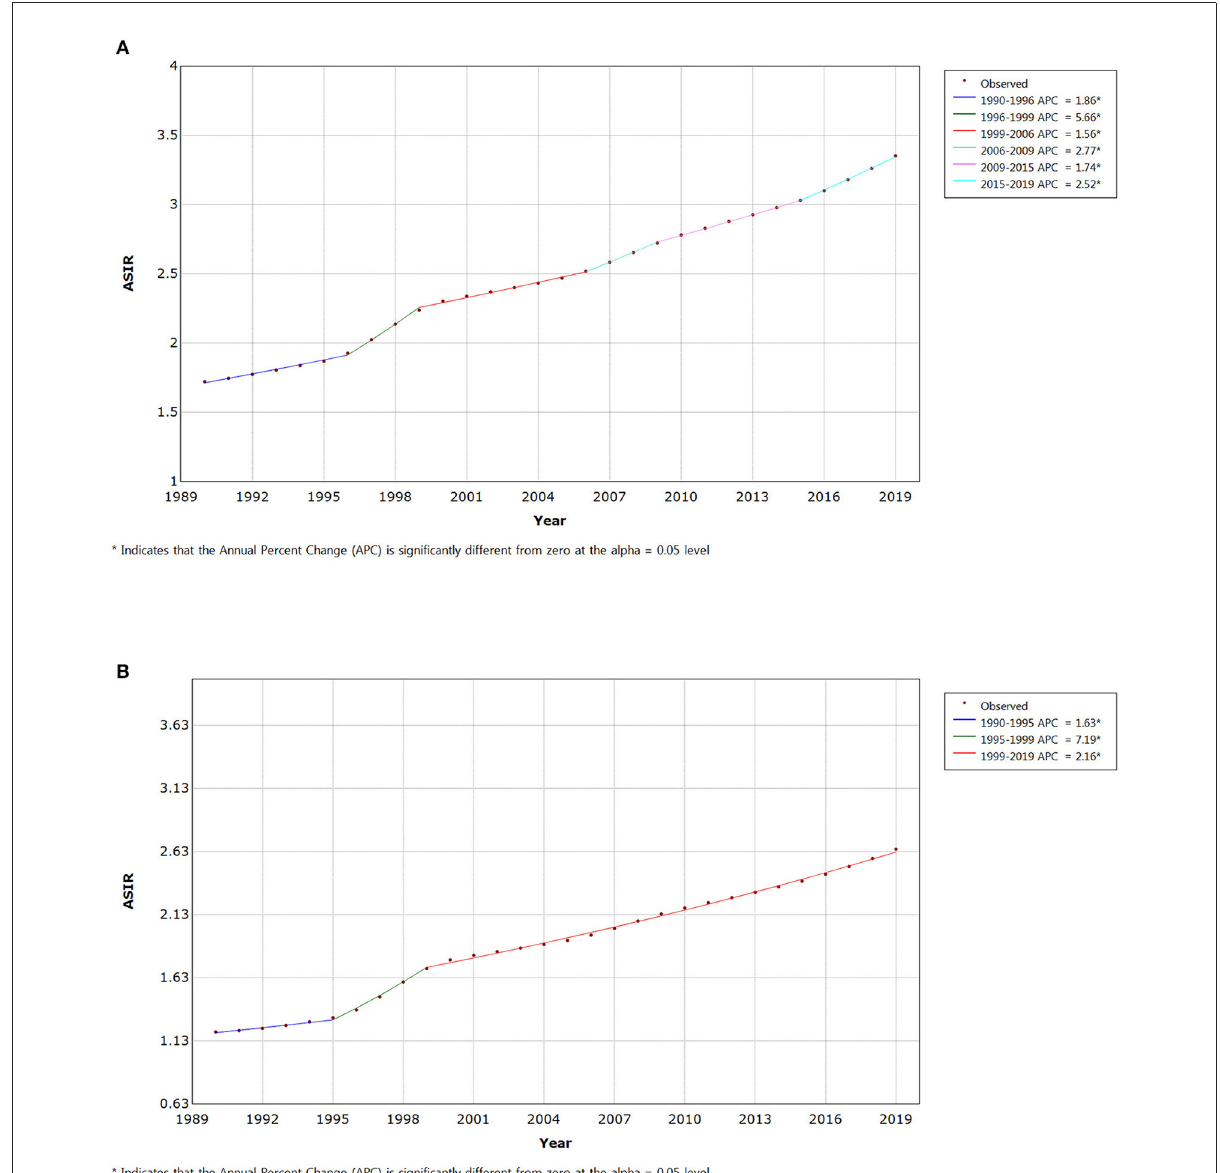
FIGURE3 Joinpoint regression analysis of the sex-specific age-standardized incidence rate for IBD in China from 1990 to 2019. (A) Age-standardized incidence rate for males. (B) Age-standardized incidence rate for females.